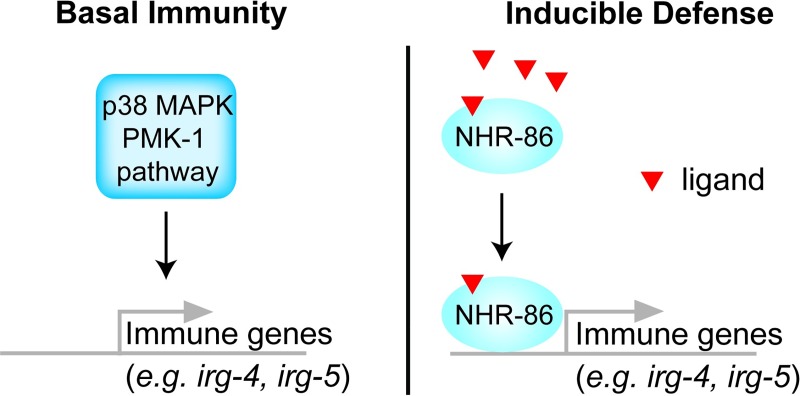
Model of NHR-86-mediated immune regulation in C. elegans.The basal expression of immune effectors such as irg-4, irg-5, mul-1 and drd-50 are ensured by p38 MAPK PMK-1. Activated NHR-86 traffics to the promoters of these and other immune effectors to drive their induction and provide protection from bacterial infection.